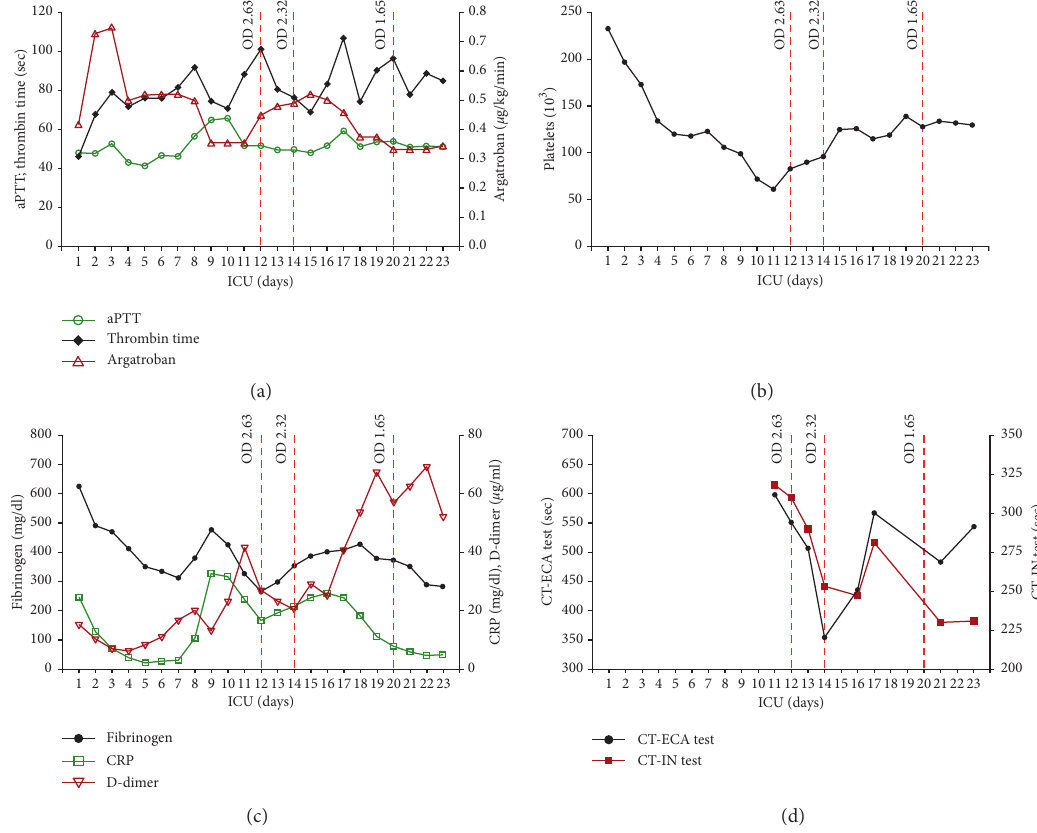
Figure 1: Clinical course in the ECMO-supported COVID-19 patient. (a) Anticoagulant argatroban was administered throughout the provision of venovenous ECMO. Anticoagulation effect. (b) Time course of platelets and results of the ELISA test (ZYMUTEST ® HIA IgG). Anti-heparin/PF4 antibodies detected by optical density (OD) read on days 12, 14, and 20 were monitored by measuring activated partial thromboplastin time (aPTT) and thrombin time (TT). (c) Time course of fibrinogen, D-dimer, and C-reactive protein (CRP). (d) Un- dulating course of coagulation time (CT) in intrinsic (IN) and ecarin (ECA) tests in contrast to the relatively uniform course of aPTT